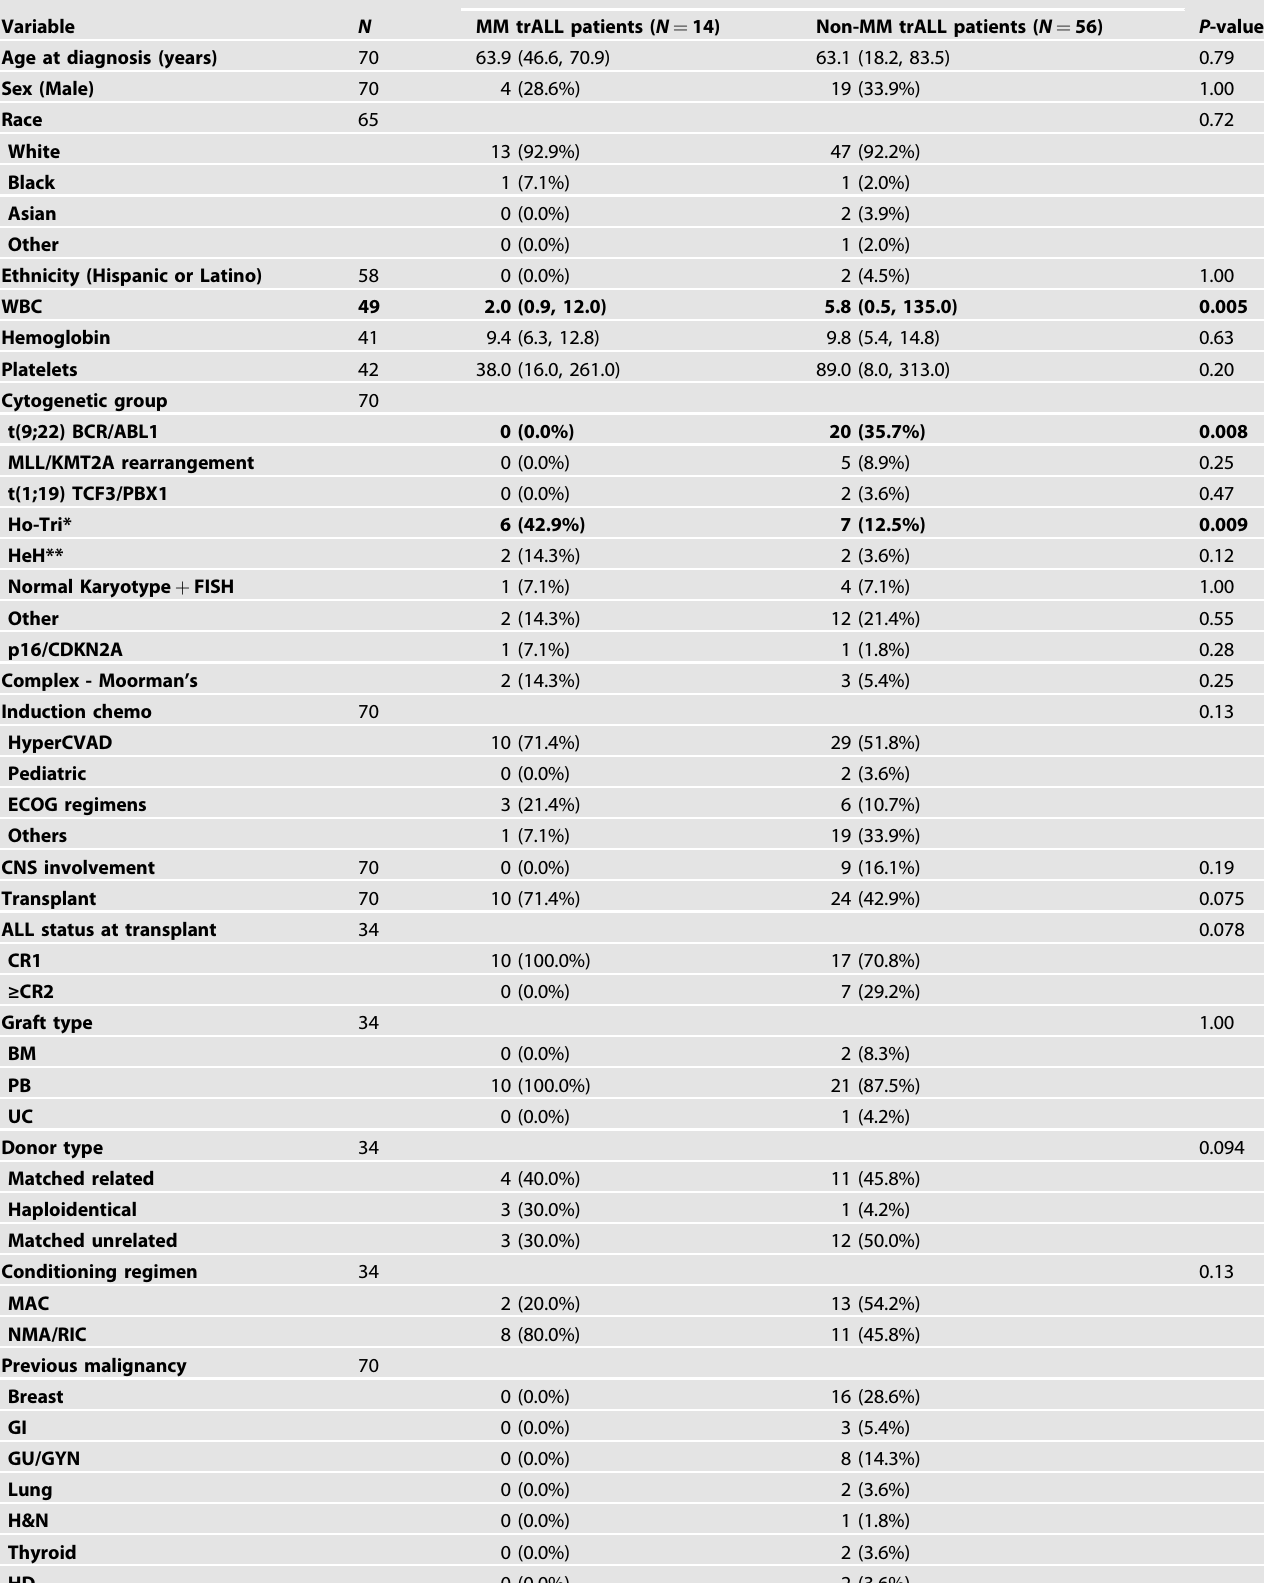
Table 1. Characteristics of trALL patients at trALL diagnosis and initial trALL